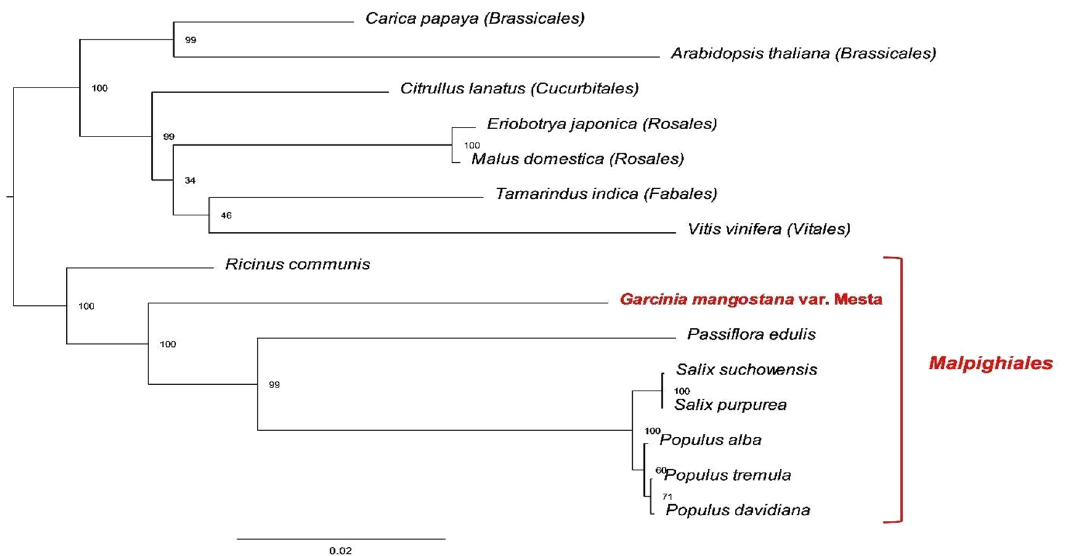
Figure 3. Phylogenomic tree (maximum likelihood) of 15 species based on 22 protein-coding genes. The parentheses and red line indicate the order